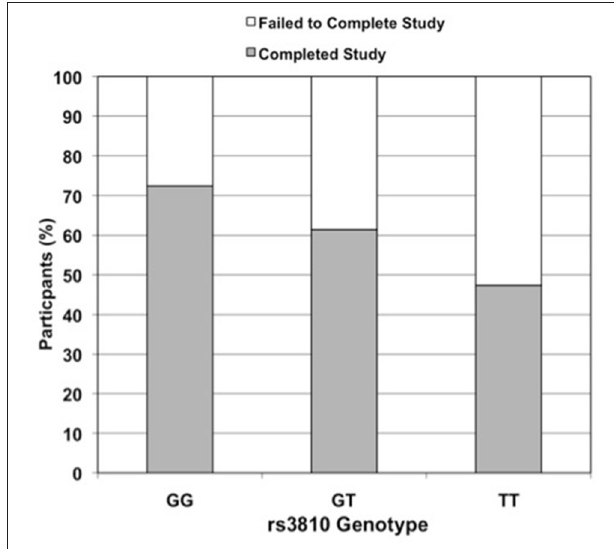
FIGURE 2 | Effect of rs3810 genotype on completion rate in STRRIDE II. Percent of subjects in STRRIDE II completing (grey filled bars) and failing to complete (open bars) the study intervention by rs3810 genotype (GG genotype n = 87, GT genotype n = 114, TT genotype n = 38; when controlled for race, gender, and exercise group effects, additive model OR = 2.0, p = 0.01 and dominant model OR = 3.5, p = 0.005). These findings were similar to those for rs2898458 and rs7508 (data not